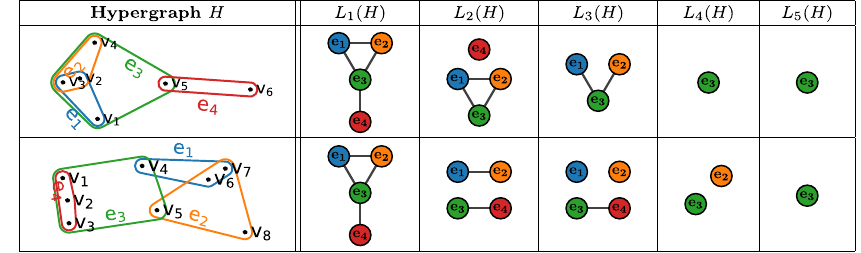
Table 1 The s -line graphs for two